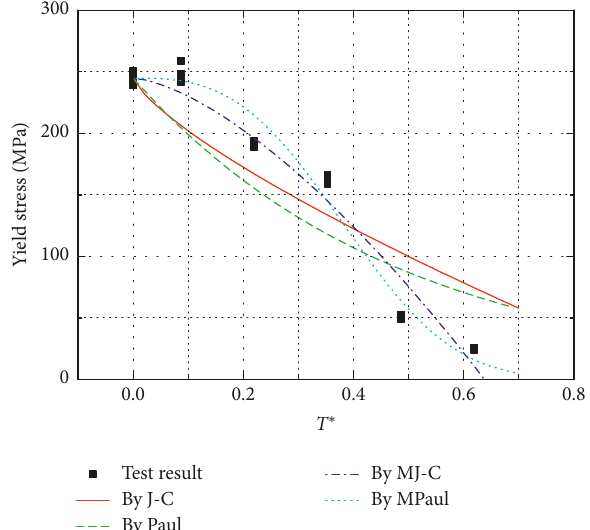
Figure 4: Yield stress at different strain rates.